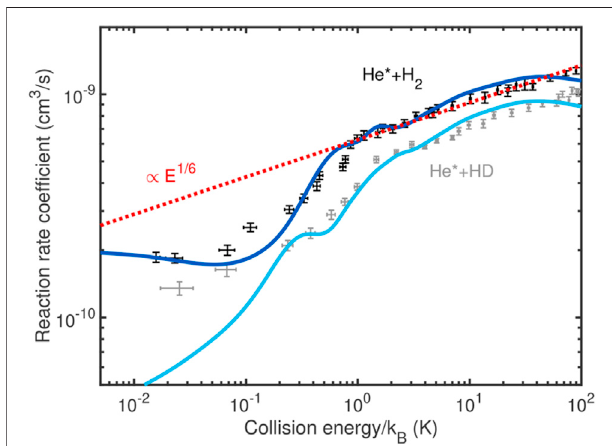
FIGURE 12 | The reaction rates for the He( 3 P,1s2p) + H 2 collision. The theoretical reaction rate is shown in blue and the experimental one in black dots with error bars over a temperature range of 0.01 K till 100 K (For the isotopic collision we use cyan and gray for the theoretical and experimentalrates,respectively.)The ab-initio theoreticalresults(basedonthe RVP complex surfaces) are in agreement with the experimental reaction rates also in the low temperature region ( < 1 K). The red dashed line is the theoretical Langevin power law (E 1/6 ). The power law matches well with the reaction rate till 0.8K, below this temperature it fails and cannot explain the observed drop. Reprinted (adapted) with permission Ref. [68]. Copyright (2019) American Chemical